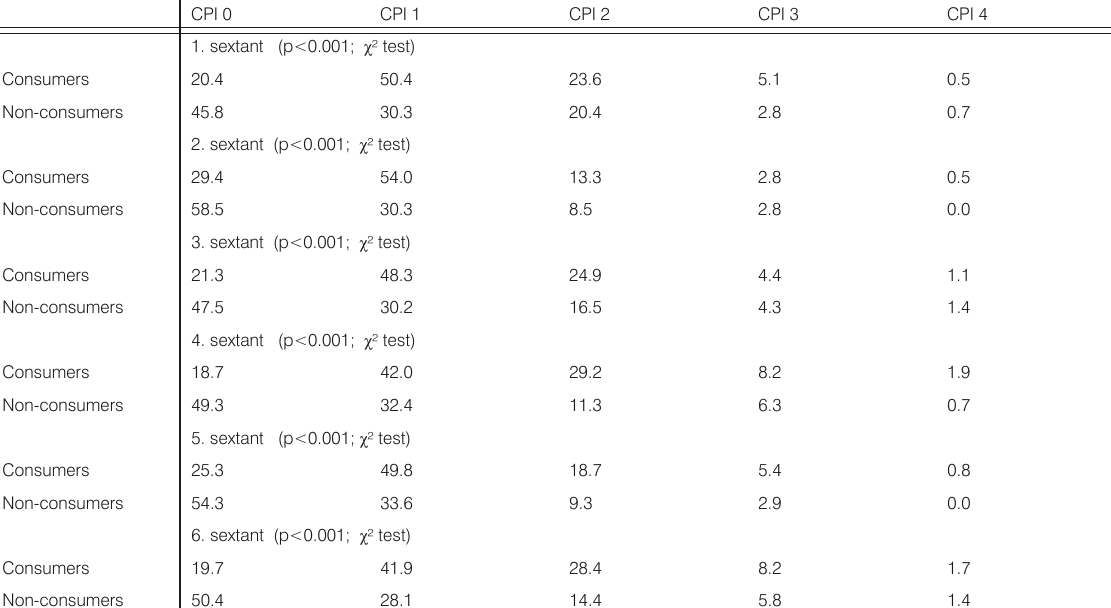
Table 6. CPITN score (%) of consumers and non-consumers in each